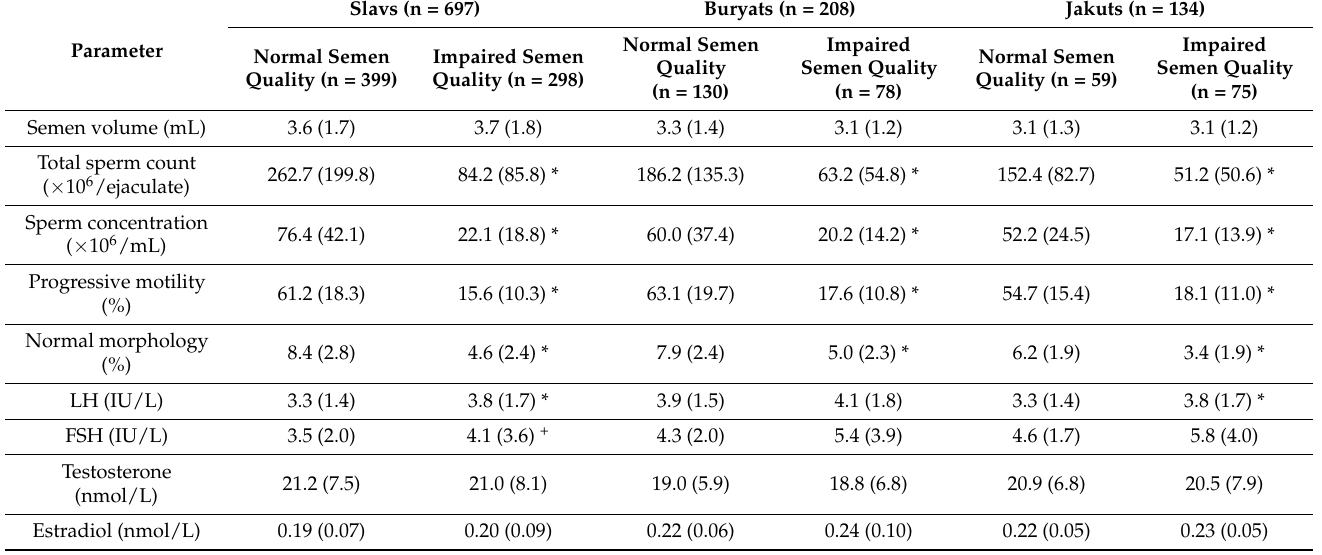
Table 4. Comparison of CAG repeat length, semen and hormonal parameters among participants with normal and impaired semen quality within the Slavic, Buryat and Yakut ethnic